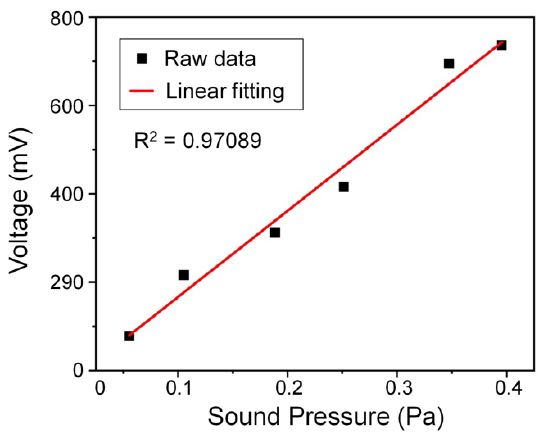
Figure 10. Linear diagram of output voltage under different sound pressures.